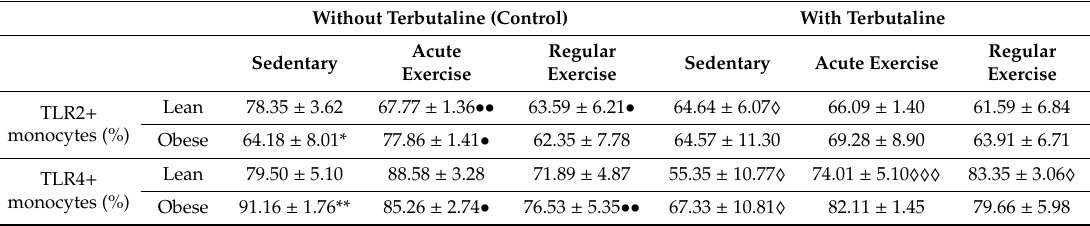
Table 3. E ff ect of β 2 adrenergic agonist terbutaline on TLR2 and TLR4 expression in circulating monocytes from lean and obese mice (sedentary, an acute and regular exercise). Without Terbutaline (Control) With Terbutaline Regular Acute Regular Sedentary Sedentary Acute Exercise Exercise Exercise